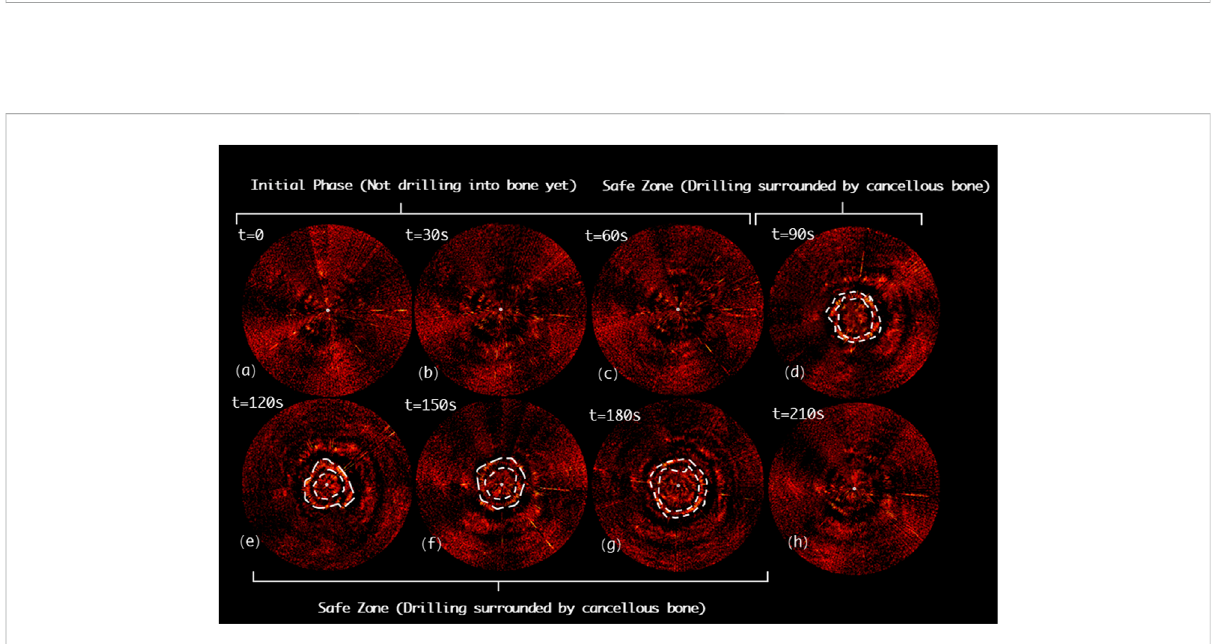
FIGURE 11 Acquired PAE images along the clinically “ correct ” path (CP) for in situ bone tissue sensing. (A-C) Initial phase; (D-G) Safe zone; (H) Final phase.